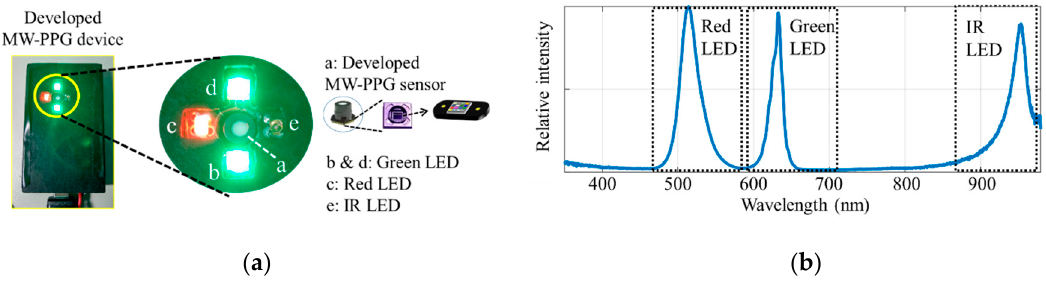
Figure 5. Signal processing procedure of blood pressure measurement using the MW-PPG sensor developed.